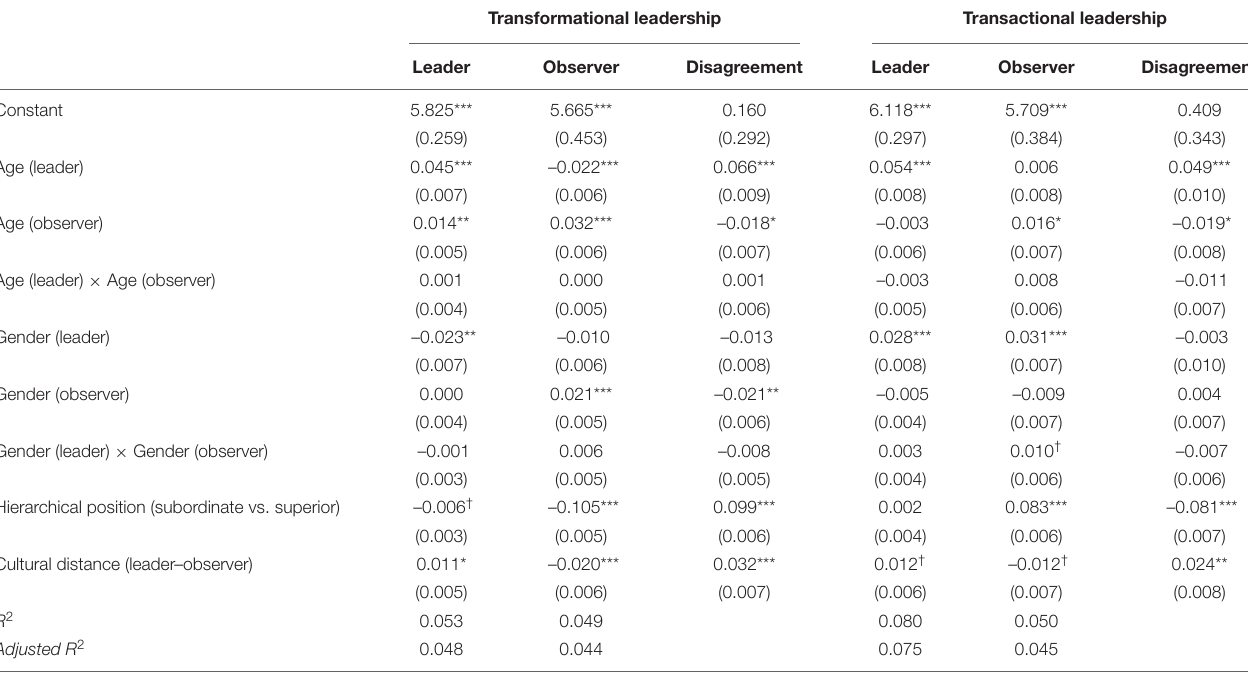
TABLE 3 | Multivariate regressions and Wald tests for leader-observer